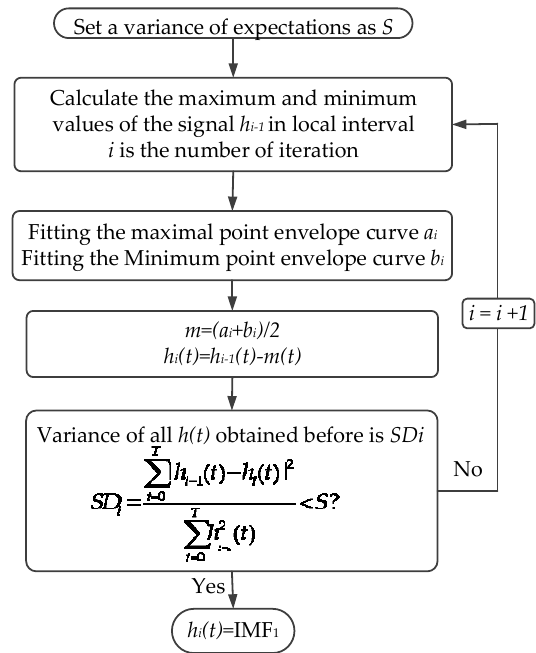
Figure 5. Process diagram of empirical mode decomposition processing signals.